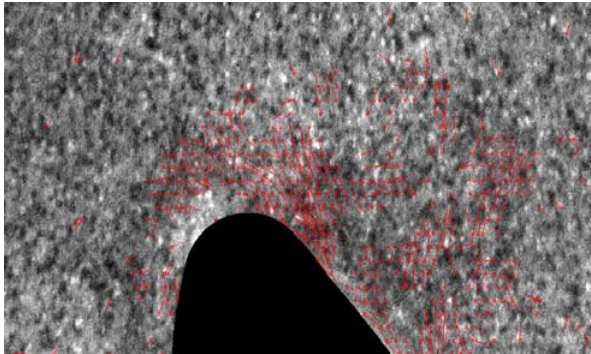
Figure 10. Visualization of tracked